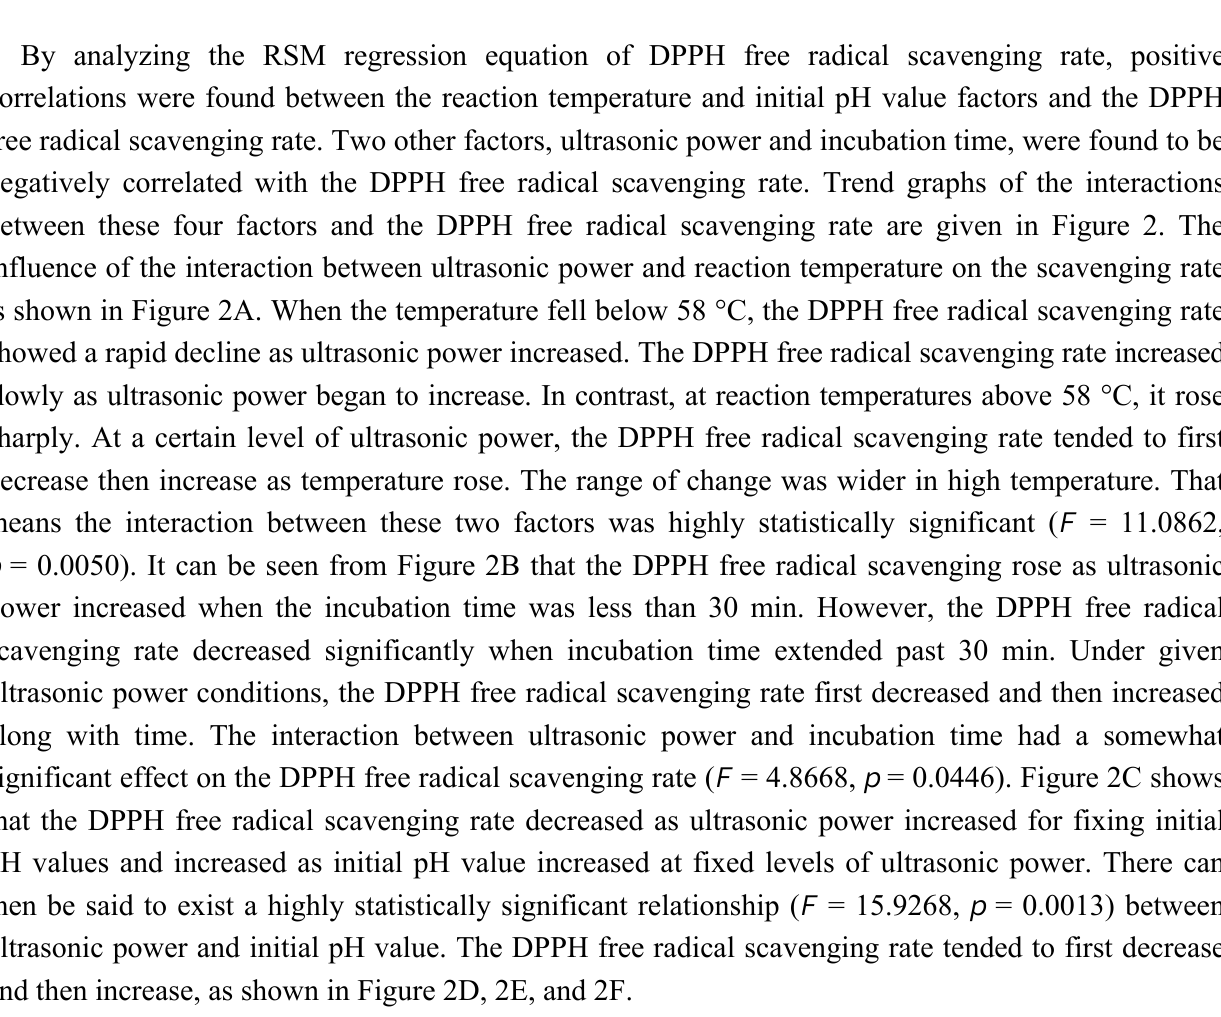
and Figure 2. Effects of various factors on scavenging rate of DPPH free radicals ( A : X 1 , B : X and X , C : X and X , D : X and X , E : X , and X , F : X and X ; X is ultrasonic X 2 1 3 1 4 2 3 2 4 3 4 1 power; X is reaction temperature; X is incubation time; X is initial pH 2 3 4